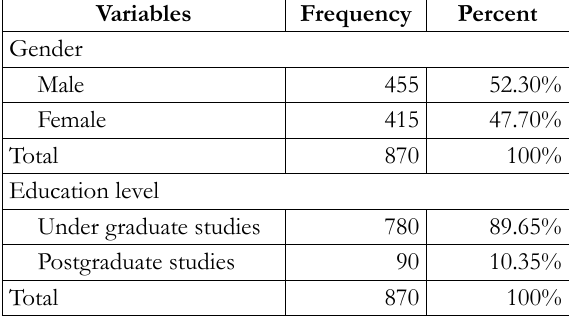
Table 1. Demographic variables n (870)